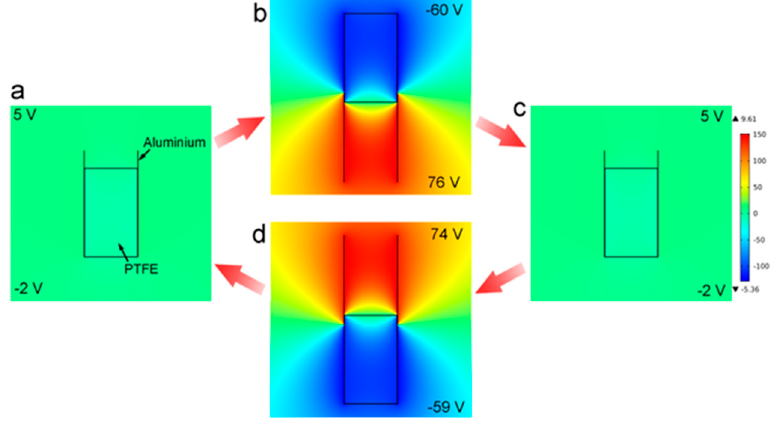
Figure 5. COMSOL Multiphysics simulation results for the CS-TENGs in different operating states. ( a ) The starting position. ( b ) The process of upward movement. ( c ) The starting position. ( d ) The downward motion process.